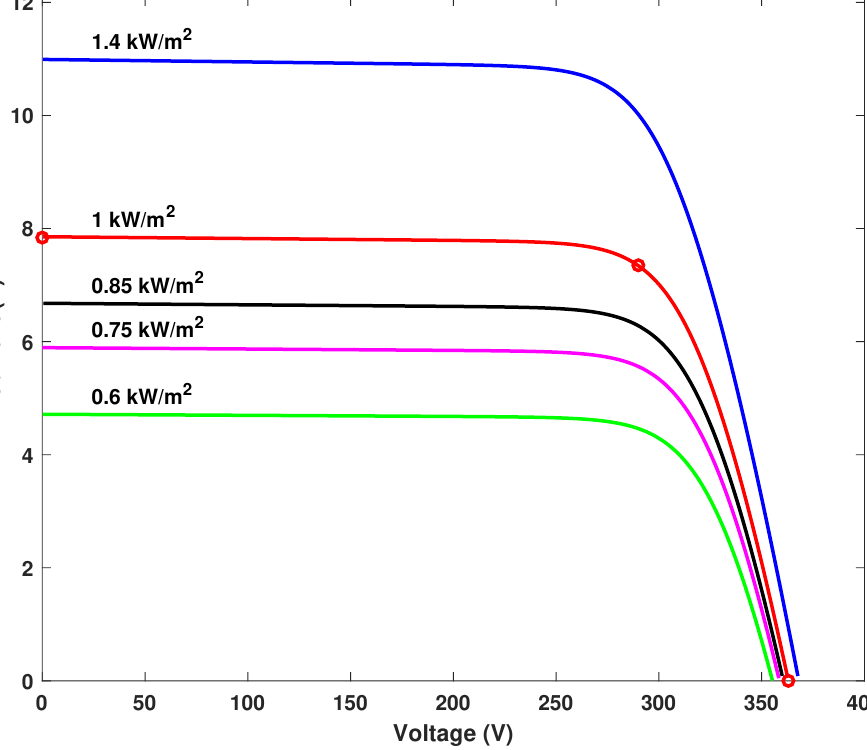
Figure 3. Characteristic curve of PV voltage and current under changing